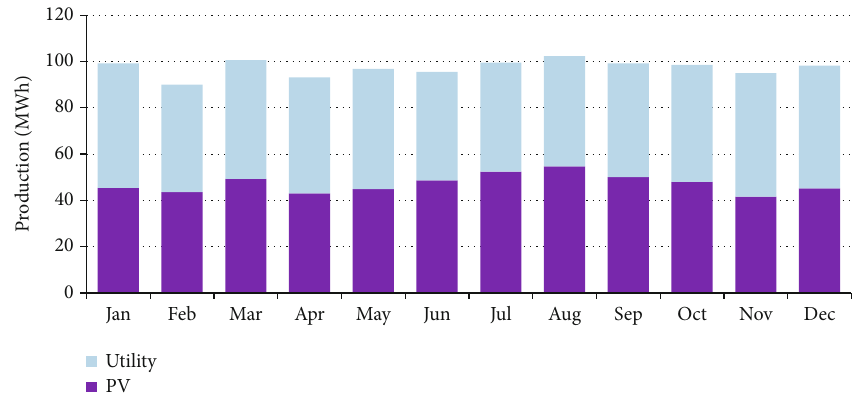
Figure 36: The electrical production for both utility and the solar PV microgrid for the proposed technology on